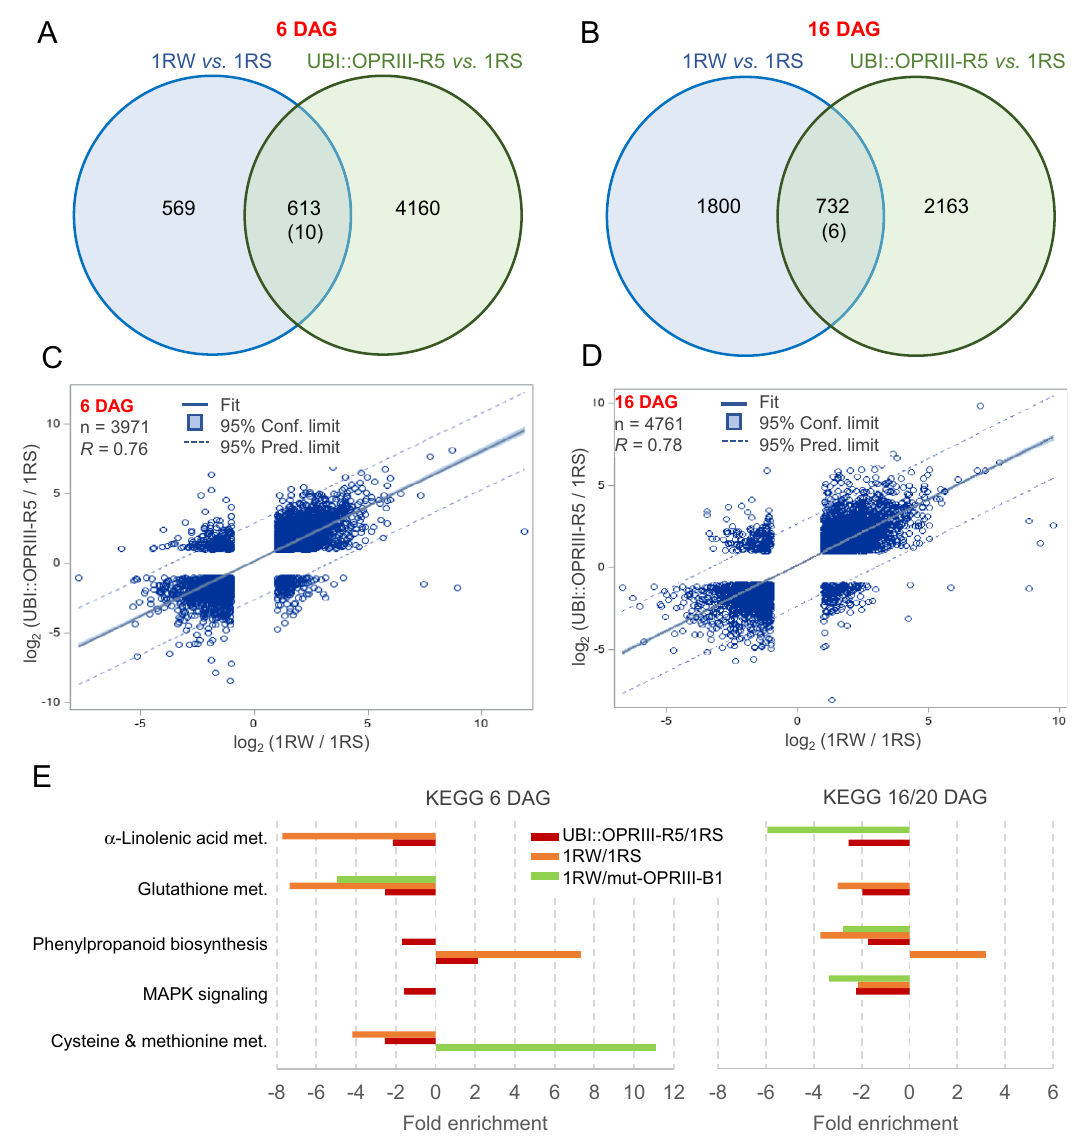
Fig. 6 | Transcriptome pro fi les of root tips in different genotypes. A – D Differ- entially expressed genes (DEGs, FDR<0.05) in comparisons between 1RW vs . 1RS and UBI::OPRIII-R5 vs .1RSat6 and16DAG. A , B Venn Diagrams.The numberinthe intersection indicates common DEGs in the same direction, and the number in parenthesisinopposite directions. C , D Regressionbetweenlog 2 expressionratios 1RW/1RS and UBI::OPRIII-R5/1RS for genes with more than two-fold changes in expression relative to 1RS (log 2 fold< − 1 or>+1) and at least one replication >0. Regressions and R 2 were calculated based on 3971 genes in ( C ) and 4,761 genes in ( D ). The central line indicates the least squares best fi t line. The signi fi cant